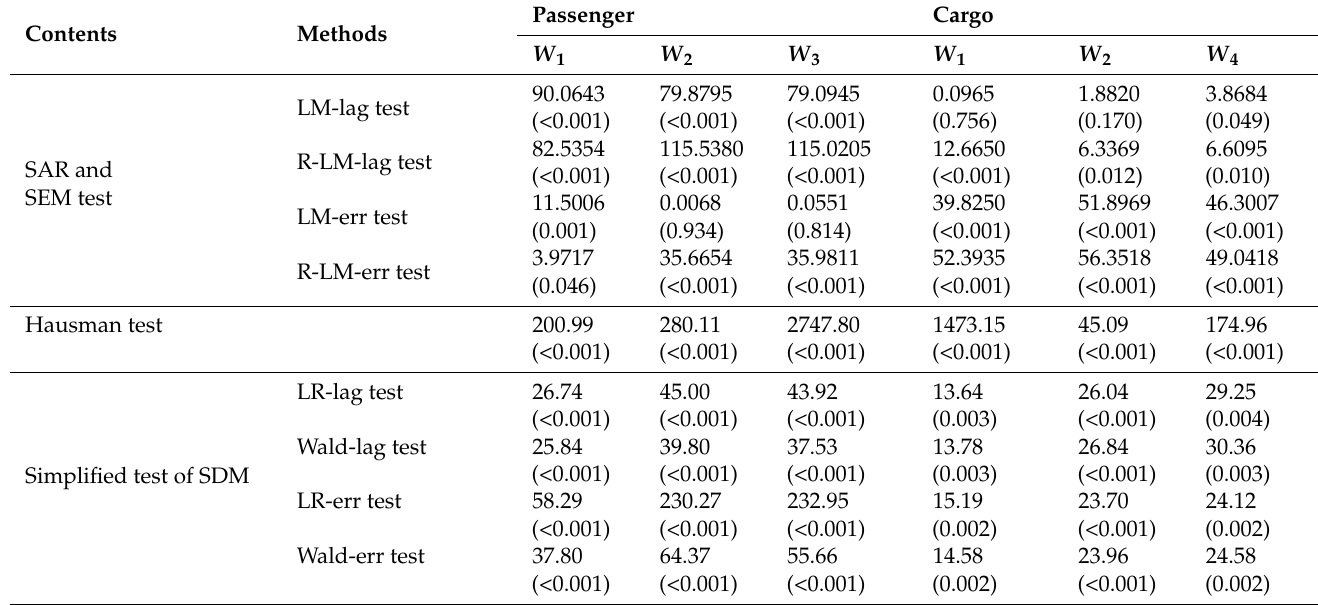
Table 3. Spatial econometric model test under W 1 , W 2 , W 3 , and W 4